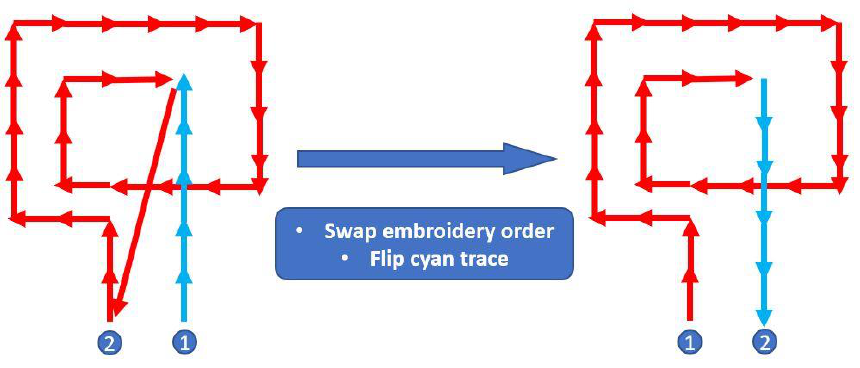
Figure 3. Correction of incorrect embroidery order and direction.